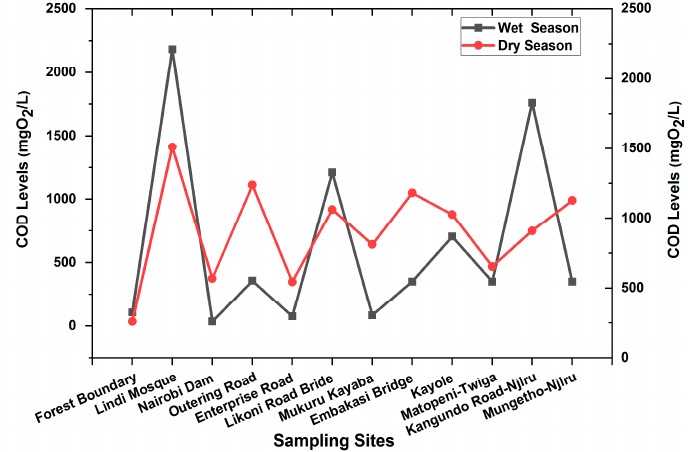
Figure 3. COD levels for Ngong River measured between April and August 2021.